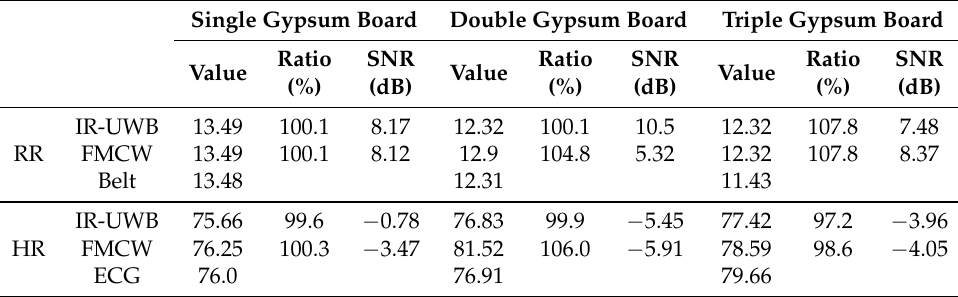
Table 8. RR and HR Results of Penetration Comparison with Multiple Gypsum